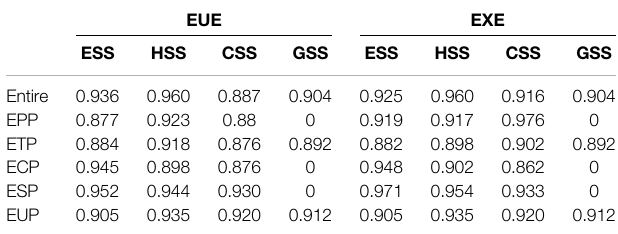
TABLE 9 | The information entropy results in winter. TABLE 10 | The information entropy results in summer.